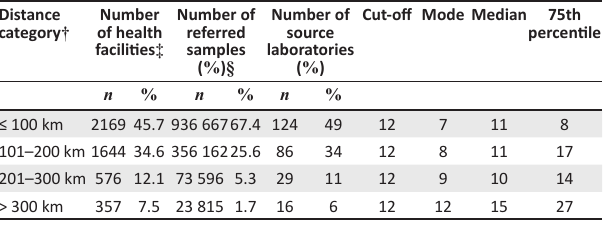
TABLE 1: Inter-laboratory CD4 testing referral laboratory-to-laboratory performance by distance categories in the 2018 calendar year for National Health Laboratory Services laboratories in South Africa.